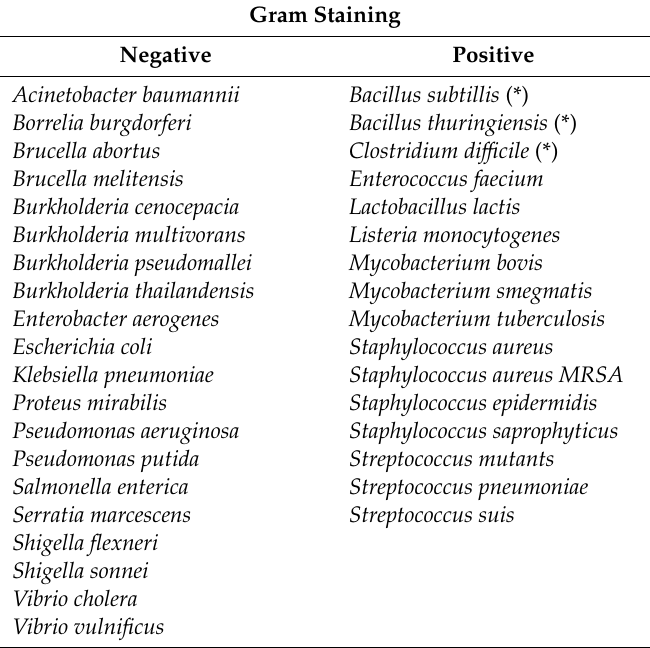
Table 1. Bacterial species. List of the 36 bacteria species that appeared in the publications included in this survey. For Enterobacter aerogenes , the name was kept as reported in the original publications although it is currently named Klebsiella aerogenes . S. enterica was serotype Typhimurium. The list was separated according to the Gram-staining properties of these bacteria with 20 species listed as Gram-negative and 16 as Gram-positive. (*) Bacillus spp. and Clostridium spp. are known to form spores. The persistence to antibiotics data for these spore-forming bacteria originated from work carried out in planktonic cultures where these bacteria were